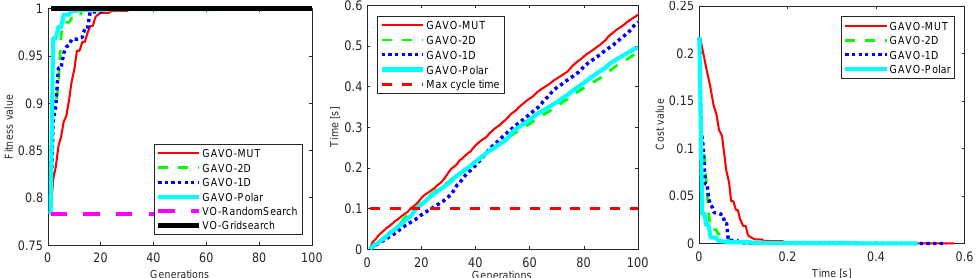
Figure 6. Results of experiments with the sparse scenario for the variations of GAVO with N = 100 and GAP = 10. VO-RandomSearch and VO-GridSearch serve as baselines that do not change with the generation. ( left ) Evolution of the fitness value with the generations, ( center ) time for a specific number of generations, ( right ) the trade-off between wall clock time and cost defined as 1-fitness The GAVO variants with different population sizes are all possible alternatives for